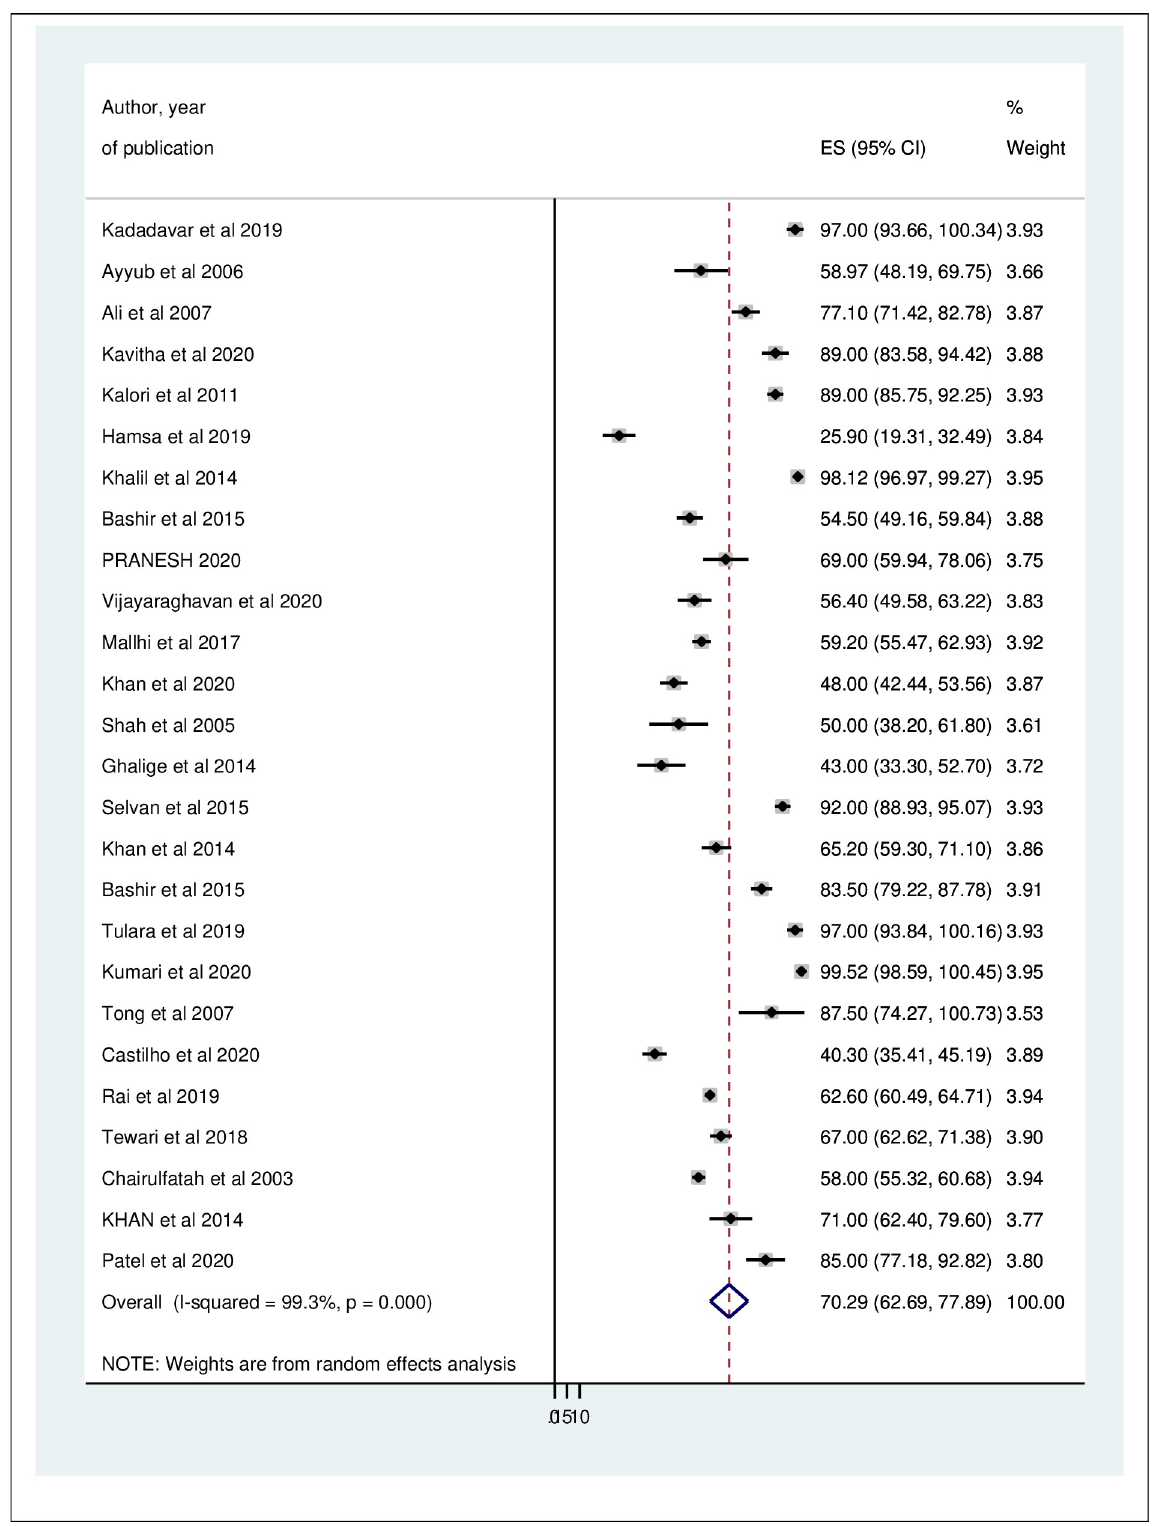
Fig 3. Forest plot displaying the magnitude of thrombocytopenia among dengue fever patients.